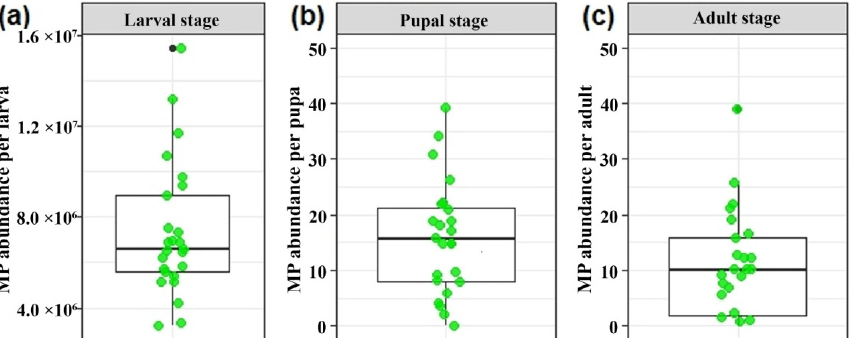
Figure 2. Abundance of MPs in mosquitoes at different life stages expressed as number of MPs per larva ( a ), per pupa ( b ), and per adult individual ( c ). The green circles show the distribution of the studied individuals. Each box includes three horizontal lines, which denote 25%, 50% (median), and 75% of the data (from 25% to 75% of the data are enclosed in a rectangle); the upper whisker extends from the first quartile to the maximum value no further than 1.5 × IQR (where IQR is the interquartile range); lower from the third quartile to the smallest value, no further than 1.5 × IQR of data; ( • ), values beyond ± 1.5 × IQR.